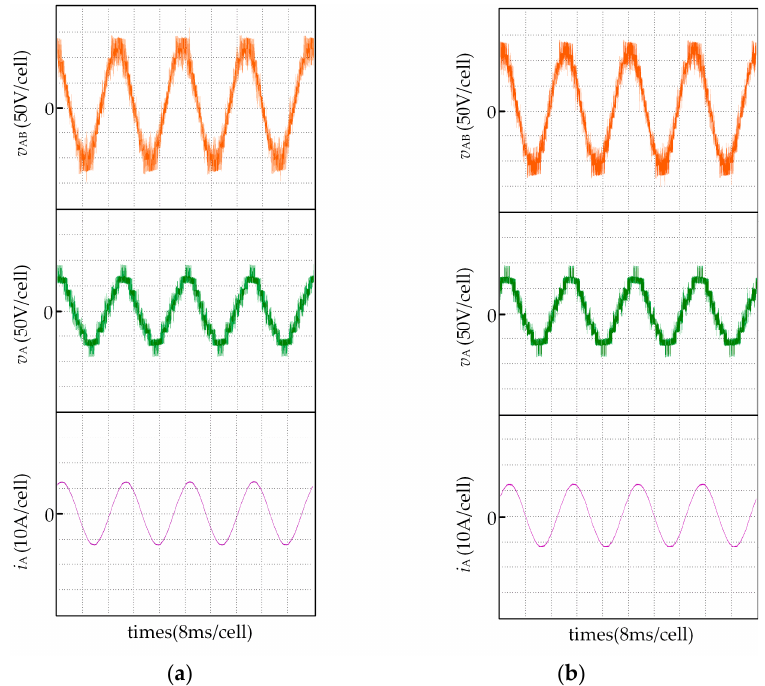
Figure 22. Experimental output waveforms of the converter at cos φ = 0.954 ( N = 4). ( a ) The proposed modulation method, ( b ) the conventional modulation method.